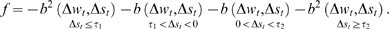
Hebbian- like STDP.Synaptic change plotted against Δst, taken from a 400th generation virtual organism evolved in a session with fitness function:Spike time measures are given in system epochs; synaptic change Δwt is given in absolute synaptic weight values. Each plot presents the average synaptic change values from 24 sessions of 1000 epochs. The error bars are set at one standard deviation.